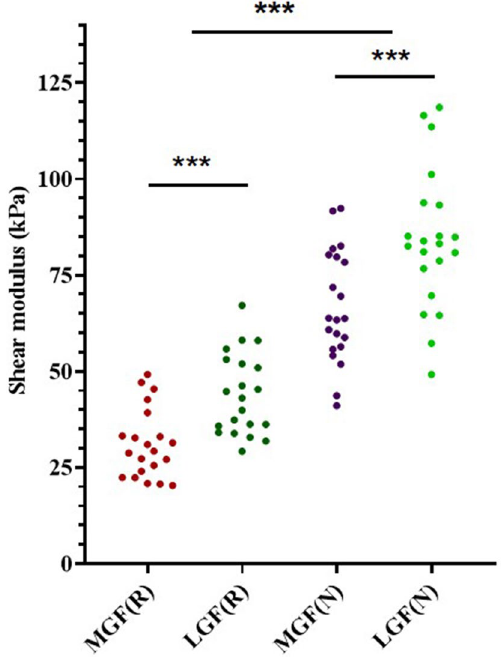
Figure 3. Variations in the elasticity of the MGF and LGF of the passive ankle joint in the relaxed position and the neutral position with the knee fully extended. *** p <